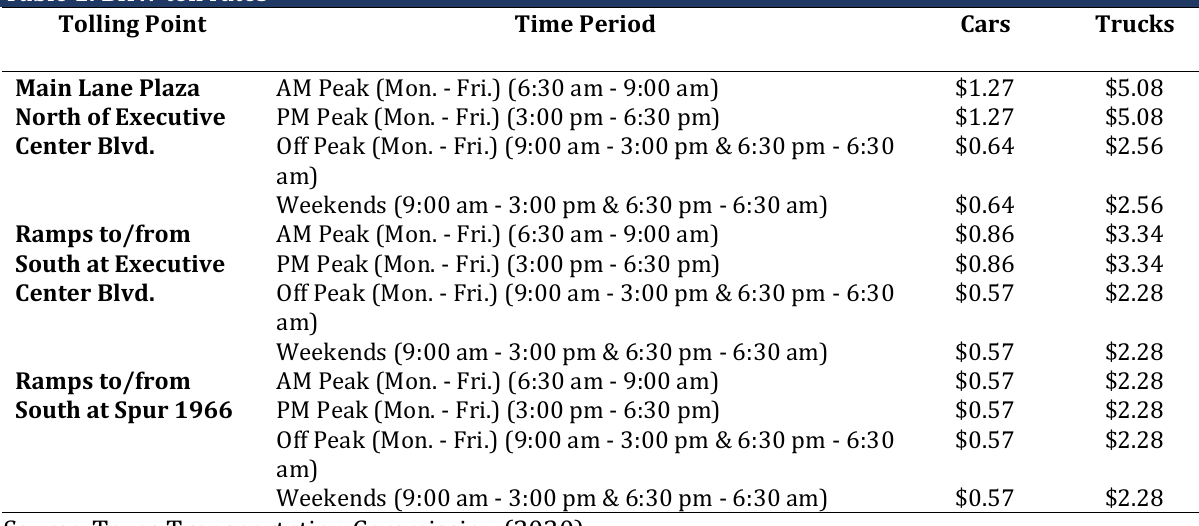
Table 1: BHW toll rates Tolling Point Time